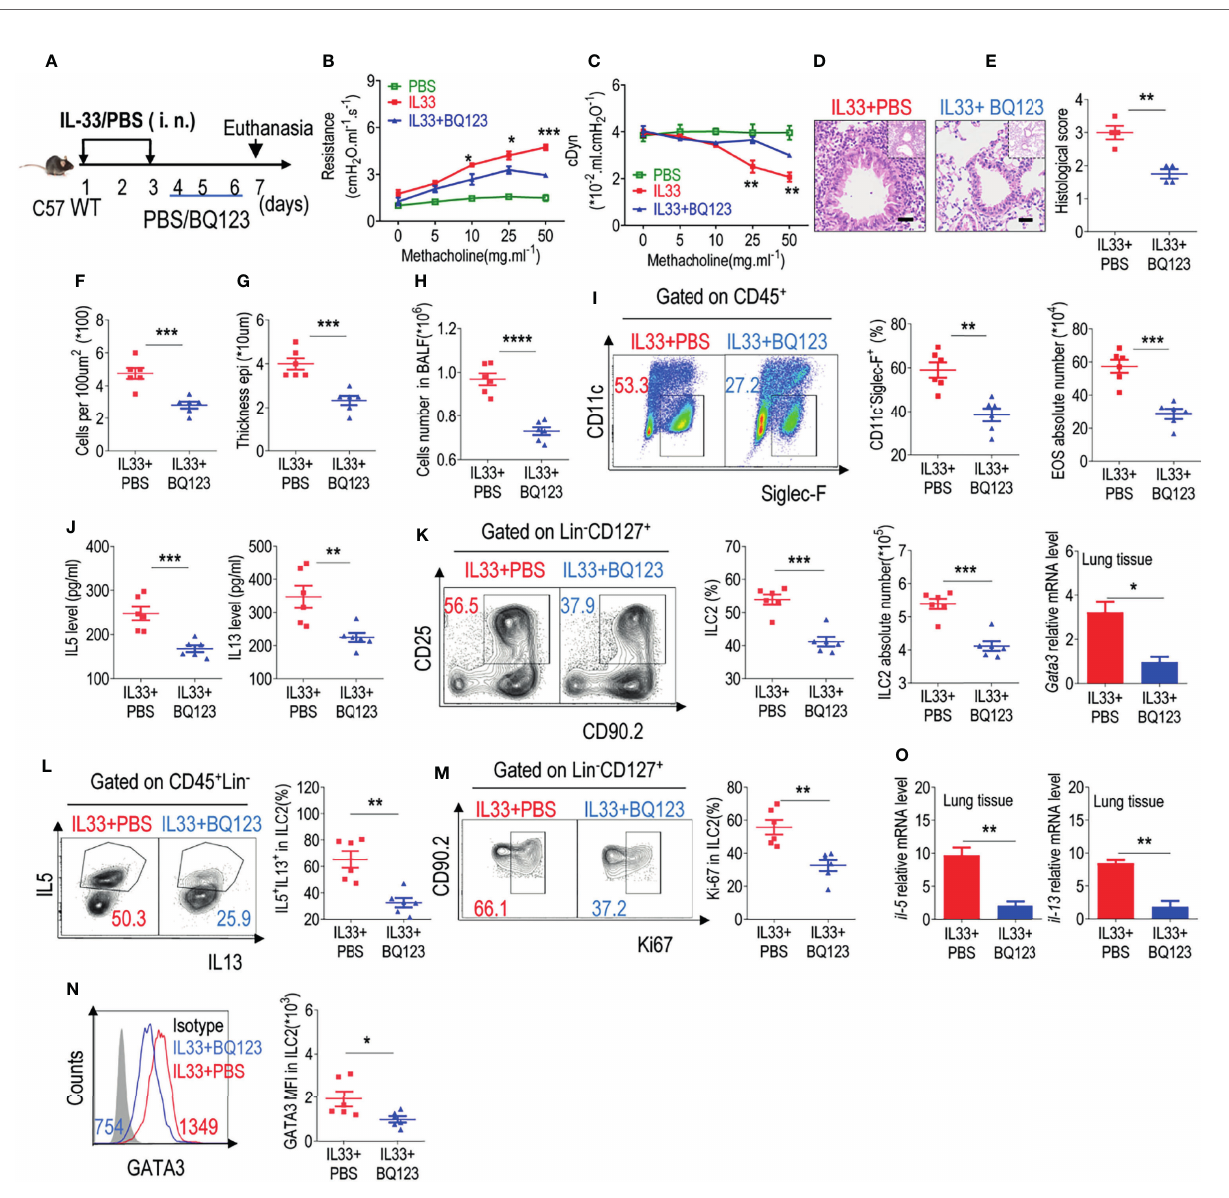
immunode fi cient NCG mice, which lacked B cells, T cells, and ILC2s. NCG recipients were intranasally administered IL-33 ( Figure 5A ). Initially, the population of CD45 + immune cells in BALF ( Figure 5B ), the population of in fi ltrated eosinophils